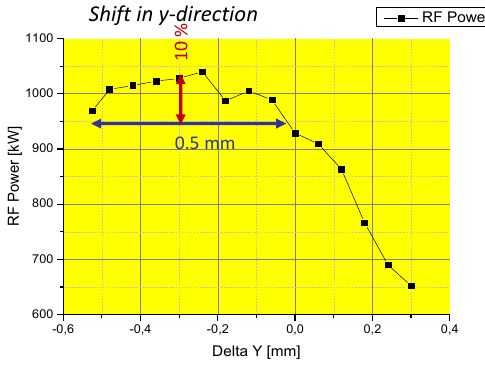
Fig. 5. Influence of the electron beam deviation (y-direction) on the RF power measurements carried out on the SP gyrotron .